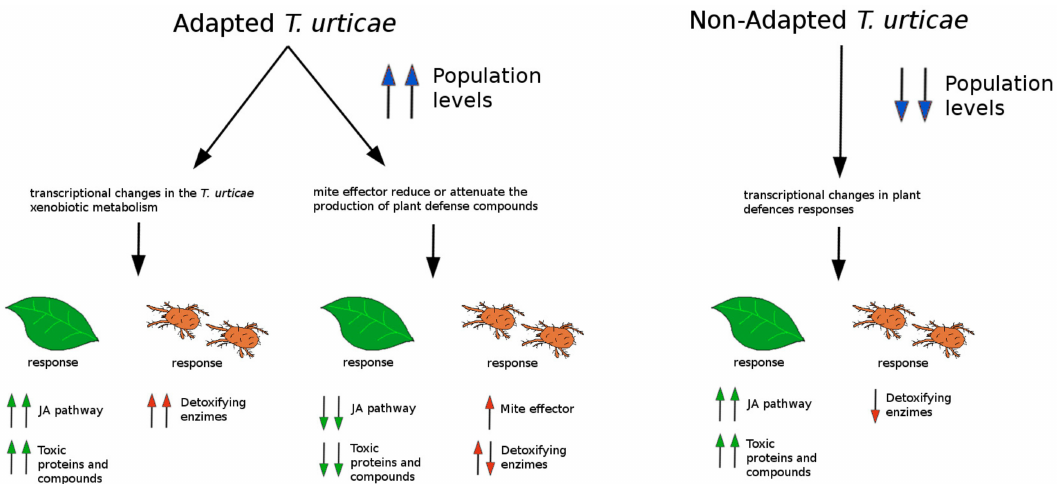
Figure 2. Interplay between host-adapted and non-adapted mites and susceptible and resistant plants. Different lines of T. urticae can be found in the field. Some lines can modify the defence mechanisms of the plant by injecting effectors into the host. Mite effectors can interfere in the activation of defence pathways. When the effector is absent from the mite, the plant responds to the infestation by activating effective defences such as the JA pathway. This JA activation gives rise the production and accumulation of terpenoids, glucosinolates, flavonoids, acyl sugars, and other defensive compounds with detrimental effects on the mite. Additionally, green-leaf volatiles (GLVs) and terpenoids can also contribute to resistance and to volatile compounds (VOCs)-IR in distal plant tissues or neighbouring plants. From the mite side, adapted lines of T. urticae are extremely efficient detoxifying host chemicals, and may manipulate host responses. This would remove the need for the detoxification of phytoalexins from the host. In contrast, non-adapted strains are recognised by the host, which responds massively by activating defensive compounds and proteins. Finally, the host itself can also be conditioned by defence priming: upon appropriate stimuli, the host can prepare to react faster and stronger to the mite attack, even upon attack by adapted lines of T. urticae , and therefore be resistant. Green arrows indicate plant responses, red arrows indicate mite responses, and blue arrows indicate the behaviour of mite